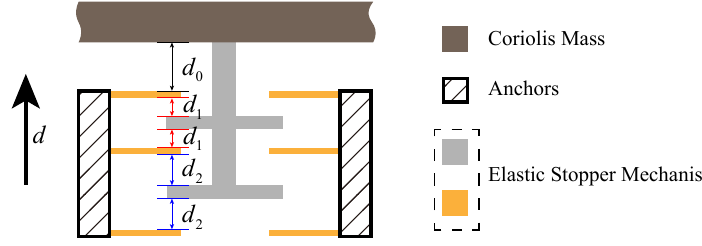
Figure 6. Structural schematic of the two-stage elastic stopper